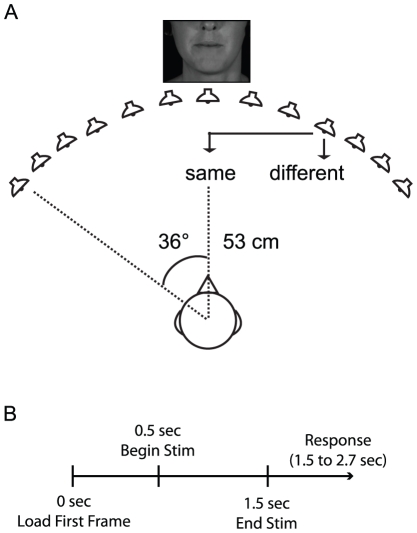
Stimulus setup and trial structure.(A) Subjects sat approximately 53 cm from a video of the speaker's face. Sounds were positioned at 13 different locations ranging from −36° to +36° in 6° increments. Subjects reported whether they perceived the presented sound to originate from the Same- or Different-Location as the speaker's mouth. Arrows point toward the perceived location and the corresponding response by the subject. (B) Trial structure. The first frame of each video was loaded 500 ms prior to starting the full video. Subjects were allowed 1.2 s to respond.